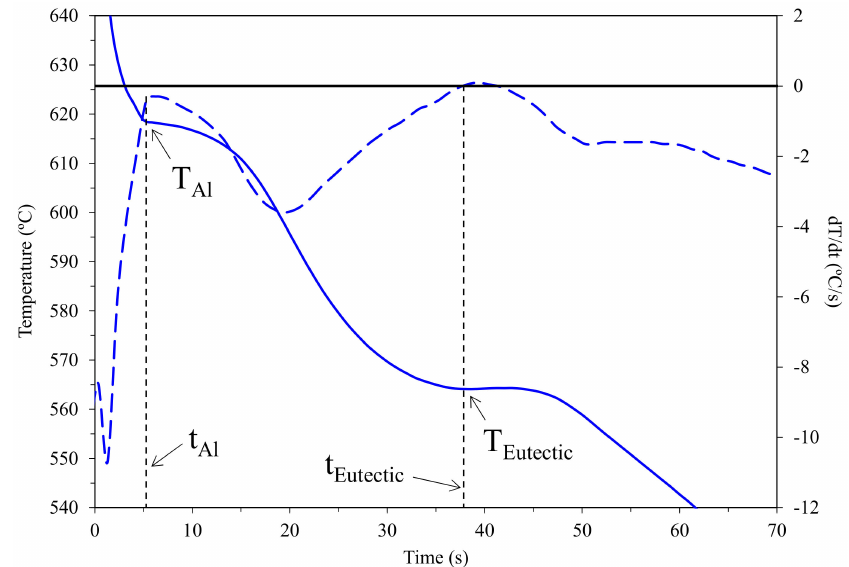
Figure 4. Characteristic solidification parameters in the cooling curve obtained from the test casting with 48 mm in diameter. The solid line corresponds to the cooling curve and the interrupted line is the first derivative curve.